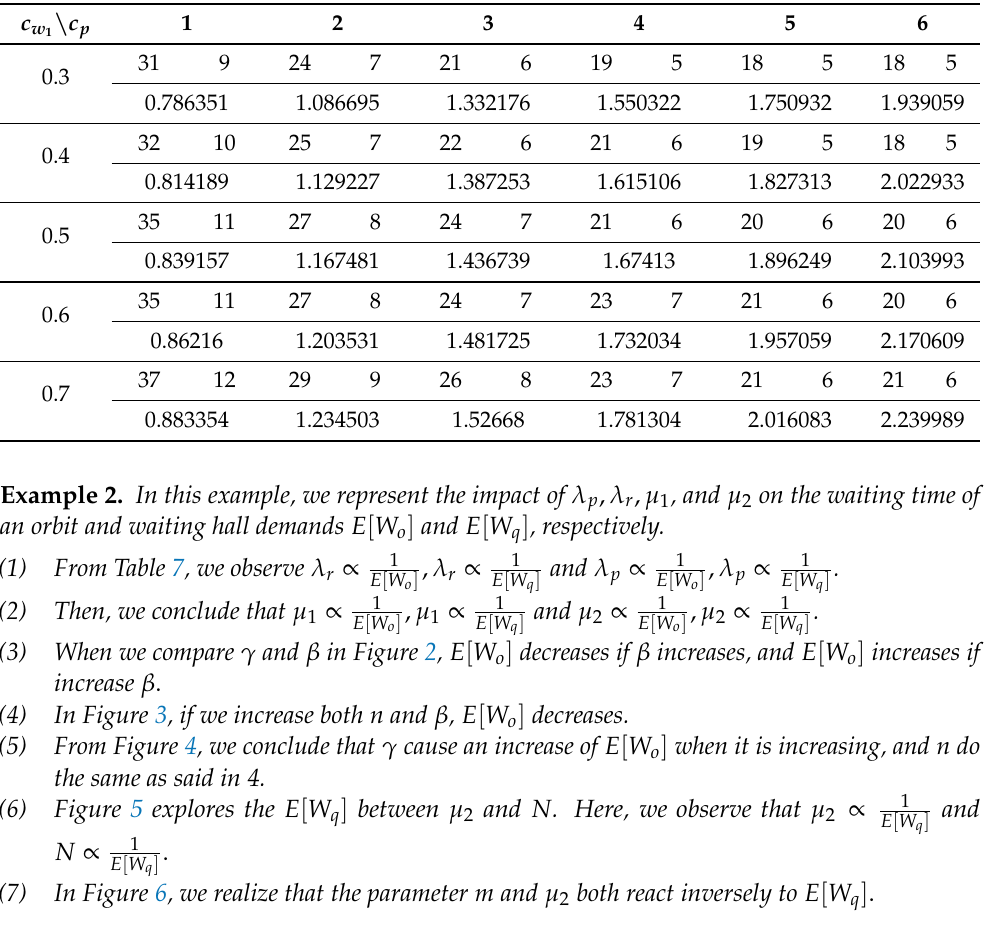
Table 6. Total expected cost c w